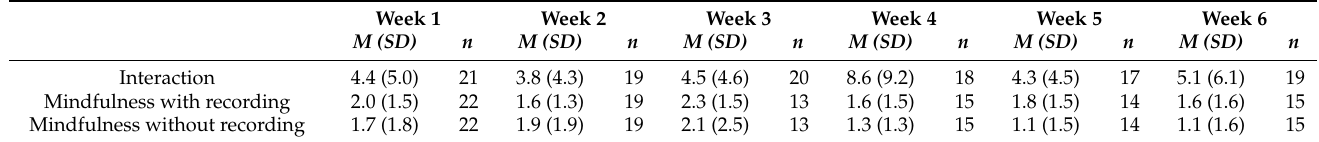
Table 4. Mean number of times weekly tasks were completed per participant in the active intervention groups.